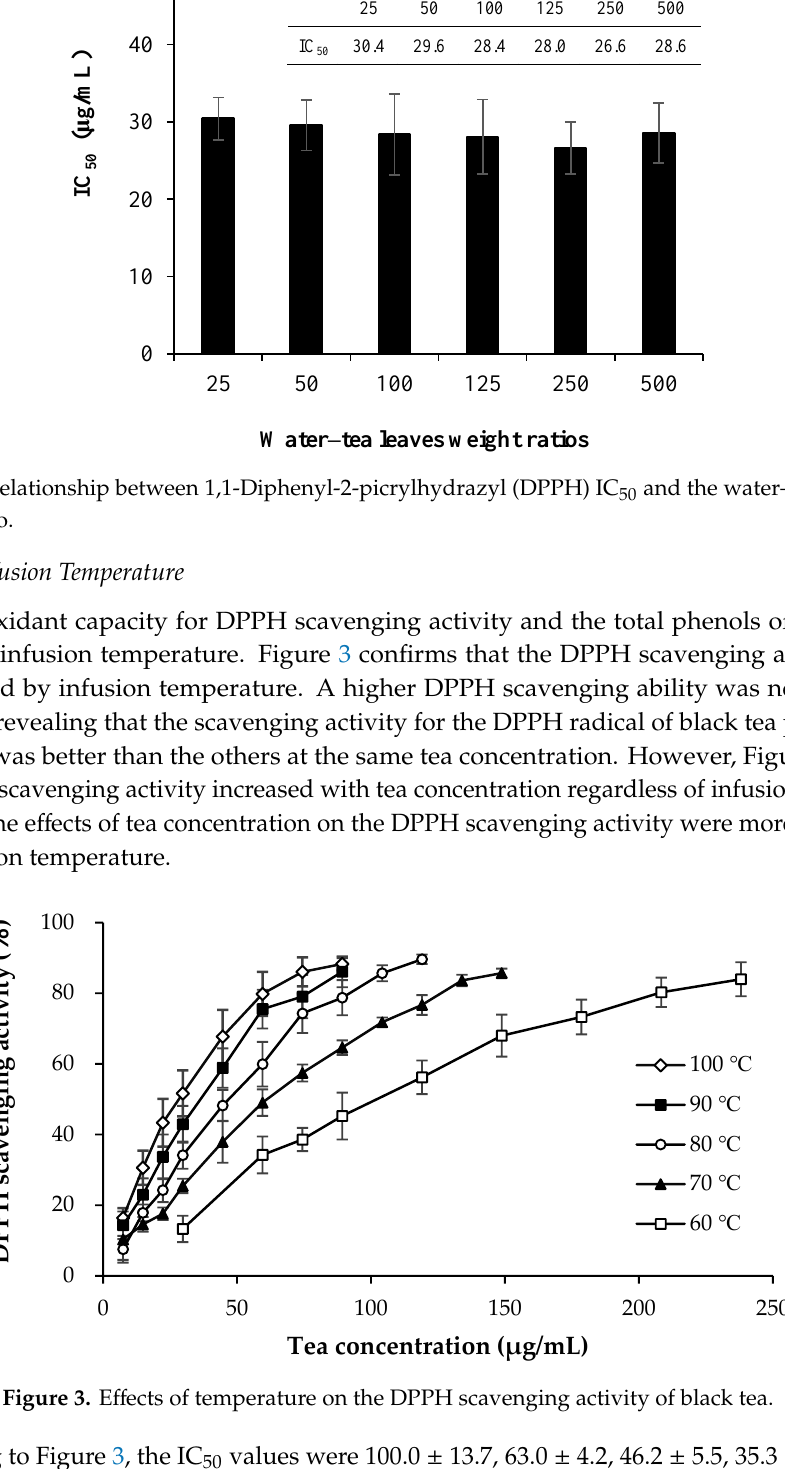
Figure 4. Effects of temperature on the DPPH IC 50 of black tea. Table 1. Effects of temperature on the total phenolic content of black tea. Temperature (°C) 60